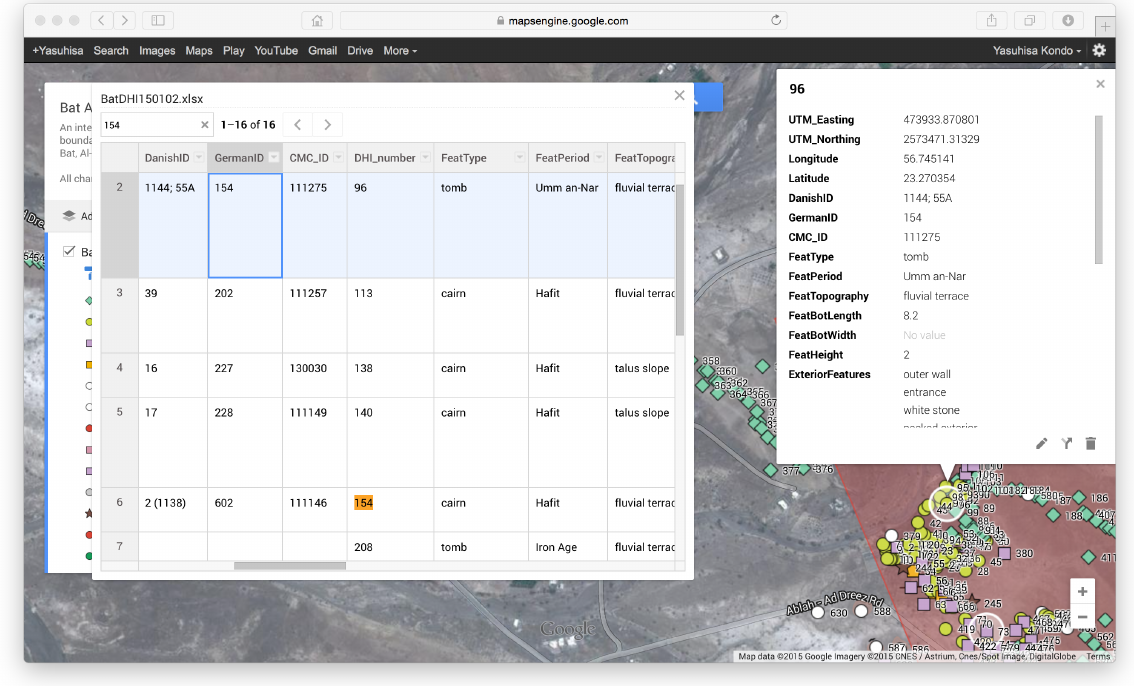
Figure 10: An example of the retrieval of a feature by attributes on Google Maps